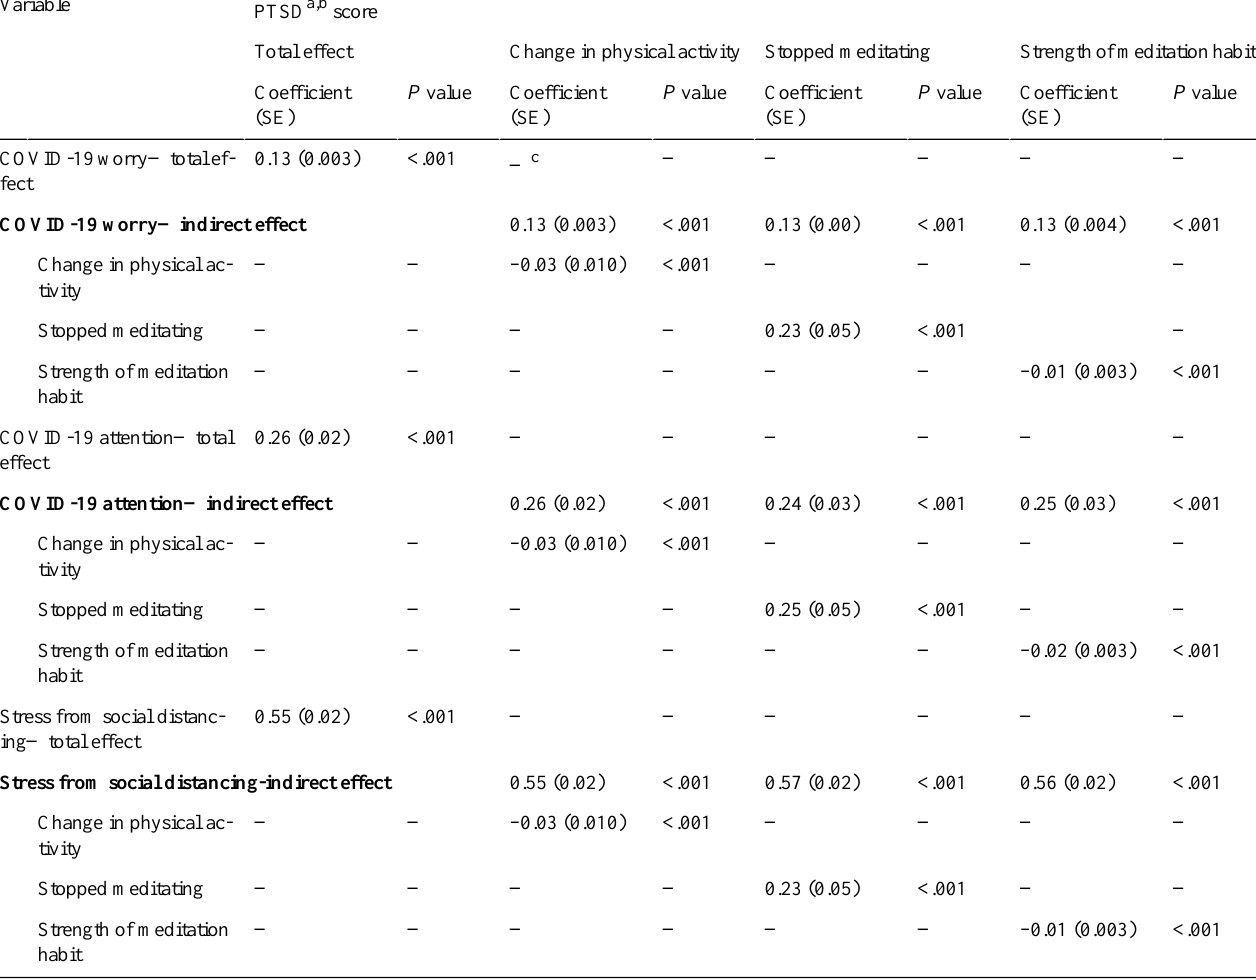
Table 7. Mediating effect of health behavior change on PTSD symptoms. This table presents the coefficients from ordinary least squares regression models of PTSD score on COVID-19–related worry, attention to news, and stress from social distancing as well as the indicated health behavior